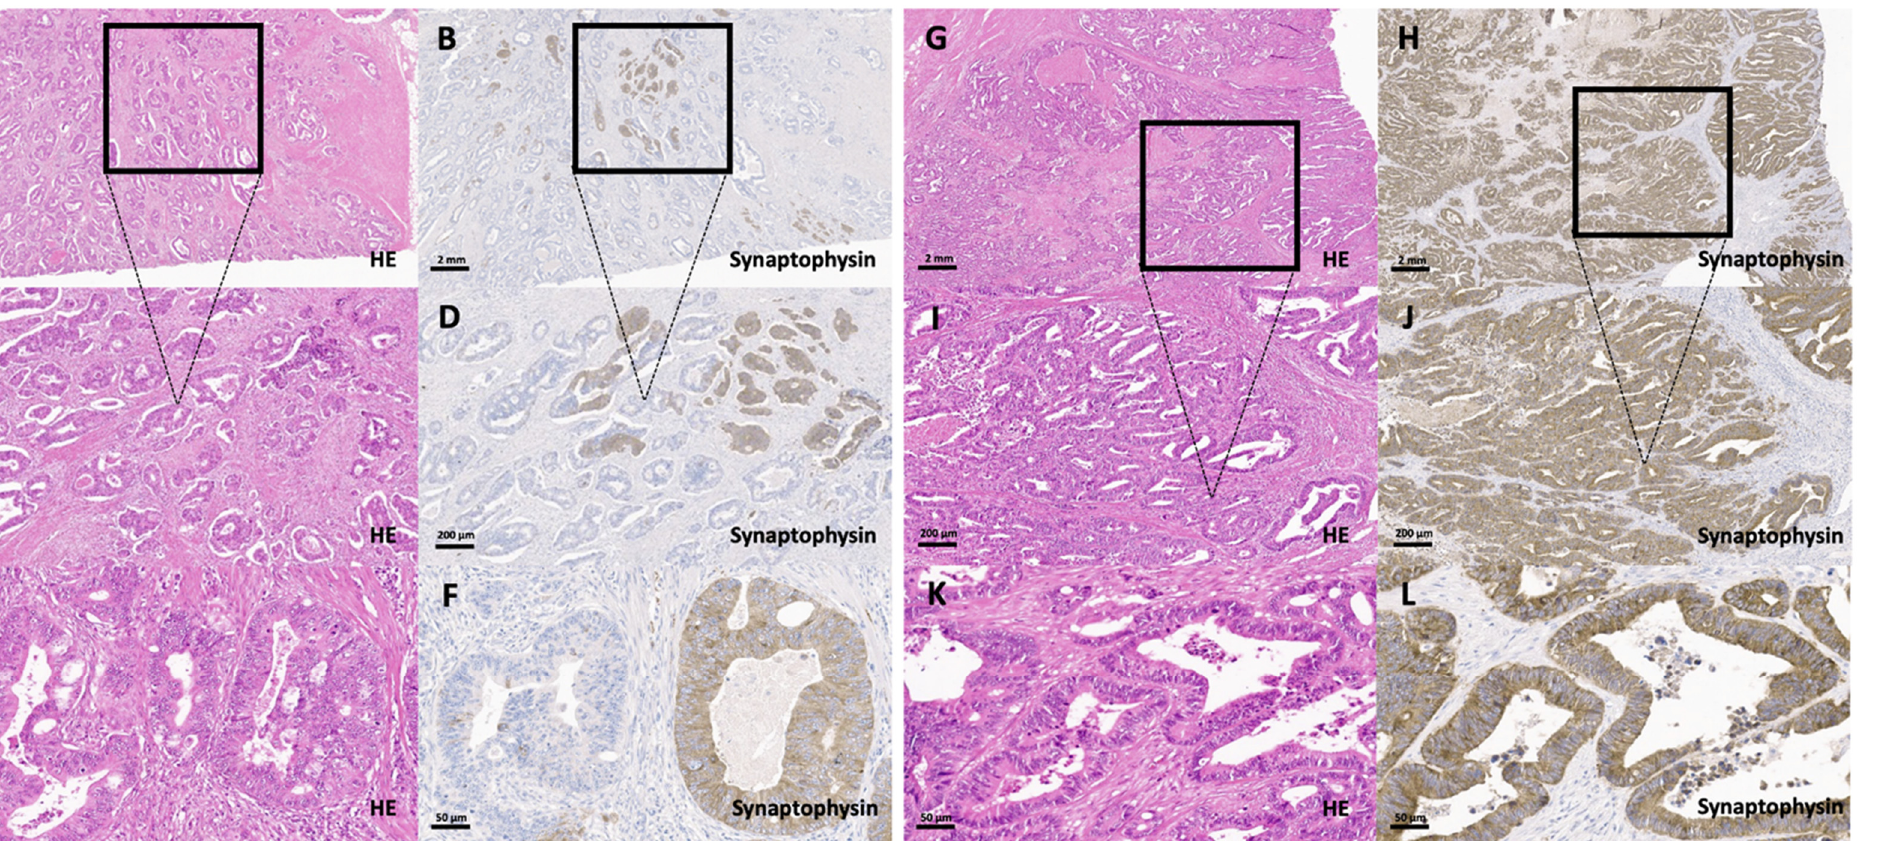
Figure 1. Synaptophysin-expressing groups in conventional colorectal adenocarcinomas with a non-neuroendocrine morphology. ( A – F ) Conventional colorectal adenocarcinoma with a non-neuroendocrine morphology (partial synaptophysin expression group; 10–29%) on H&E ( A (2×), C (20×), E (40×)) and synaptophysin staining ( B (2×), D (20×), F (40×)) with a group of synaptophysin-positive cells accounting for 15% of the whole tumor. ( E – H ) Conventional colorectal adenocarcinoma with a non-neuroendocrine morphology with a diffuse synaptophysin expression in all tumor cells on H&E ( G (2×), I (20×), K (40×)) and synaptophysin staining ( H (2×), J (20×), L (40×)).